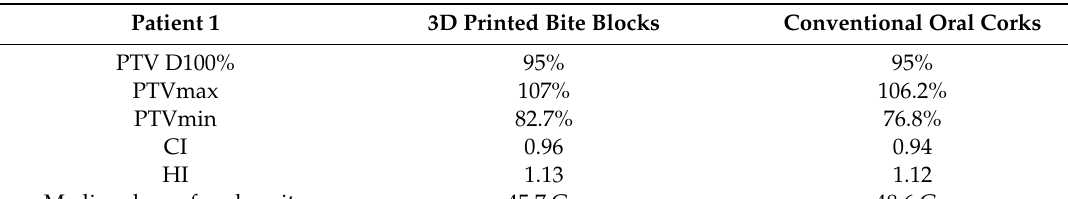
Table 1. Dosimetry of Patient 1.